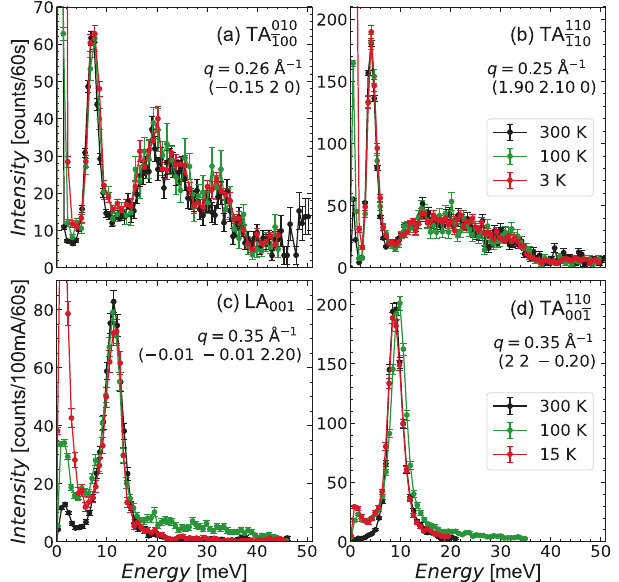
Fig. 4 | Temperature dependence of representative energy scans across the acousticphonondispersionsshowninFig.3. Subplots( a , b )havebeenmeasured by inelastic neutron scattering, and ( c , d ) by inelastic X-ray scattering. The mode polarization and wavevector are indicated in each subplot. Vertical error bars are s.d. arising from counting statistics.